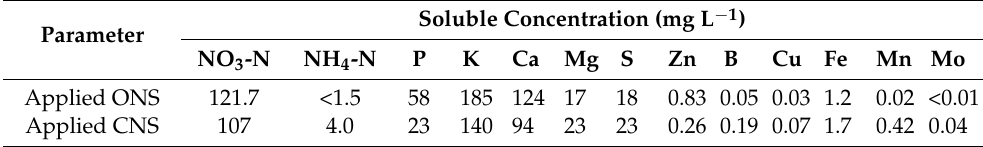
Table 3. Soluble nutrient content of the conventional mineral nutrient solution and the organic nutrient solution.